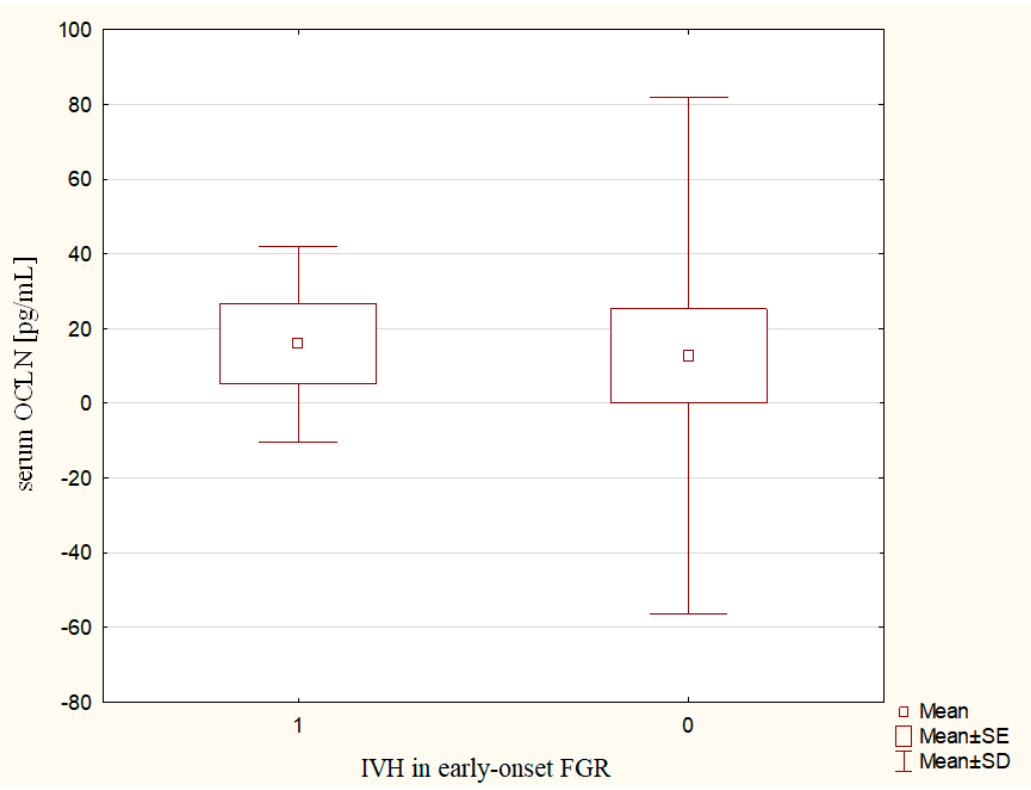
Figure 1. The maternal serum OCLN concentrations in relation to newborns IVH in the early-onset